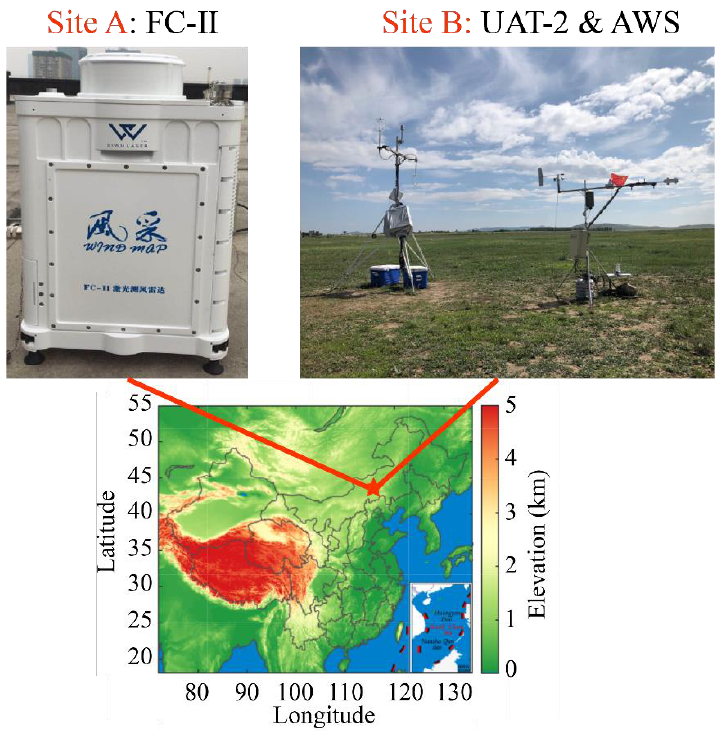
Figure 1. Topographic map of the experimental site. The straight-line distance between the two sites is approximately 500 m. The portable Doppler wind lidar (FC-II) was deployed at Site A. The ultrasonic anemometer thermometer (UAT-2) was deployed at Site B. The location of the field experiment was at the southern edge of Xilin Gol League (pentagram in the button map).